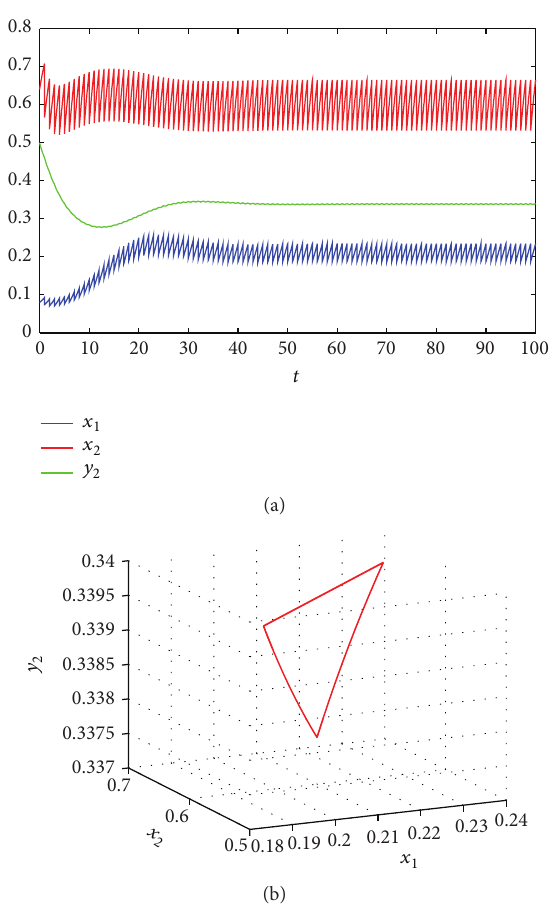
Figure 3: The permanence of system (3) with initial values of (0) = 0.1 , 𝑥 (0) = 0.8 , 𝑦 (0) = 0.5 , and 𝑑 = 0.2 , and other 𝑥 1 2 2 2 parameters are the same as those in Figure 1. Obviously, all these species can coexist and their densities go into a bounded region. (a) Time series of 𝑥 1 , 𝑥 2 , and 𝑦 2 , which indicate that the solution of (3) goes into a bounded region to be permanent. (b) Phase portrait of system (3), which implies a positive periodic